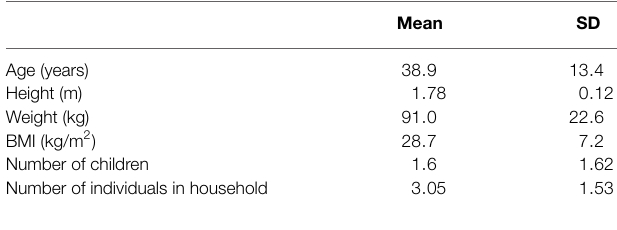
TABLE 1 | Sociodemographic characteristics of the study participants I .